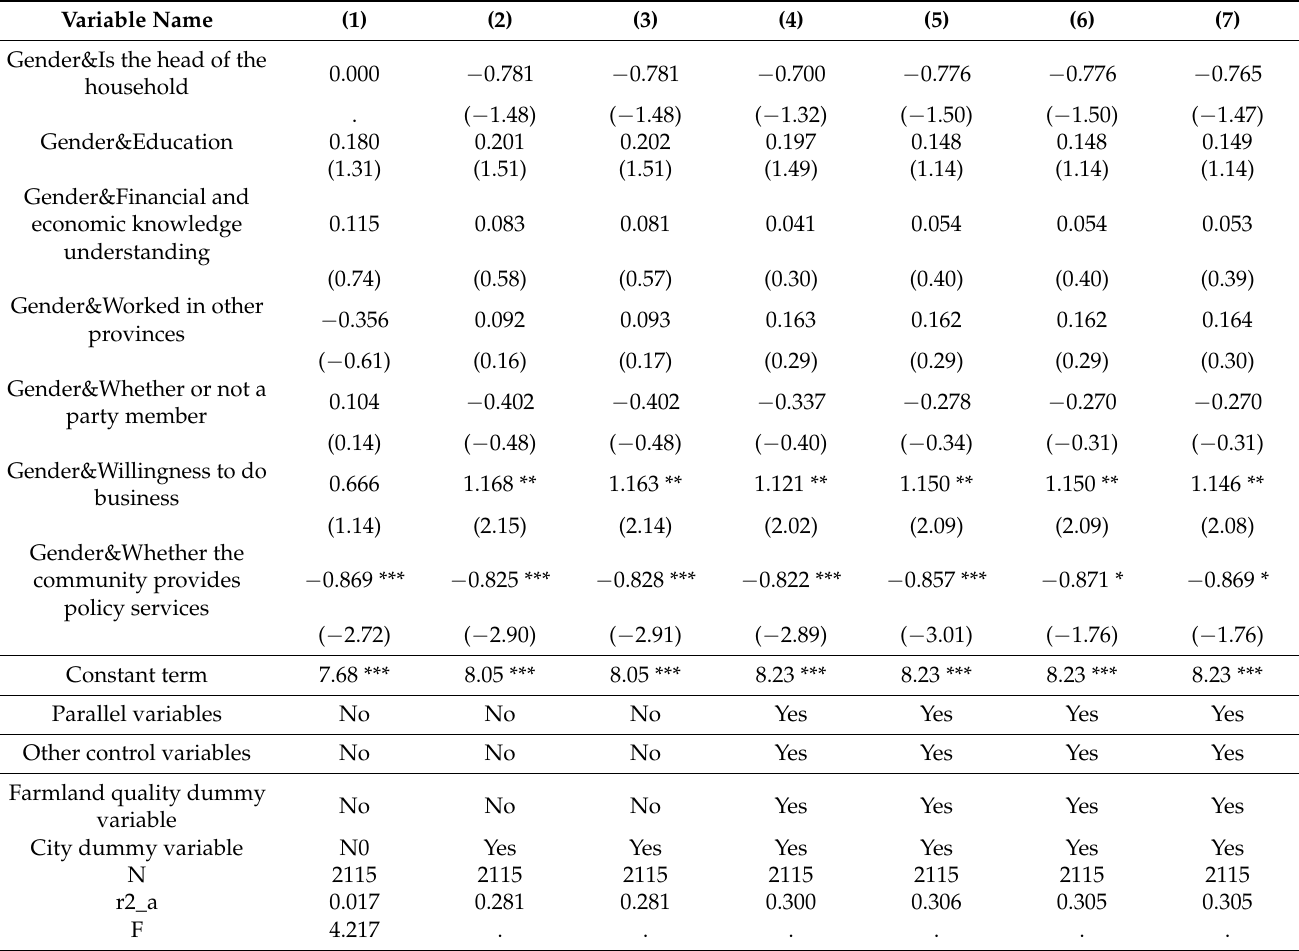
Table 6. Mechanism